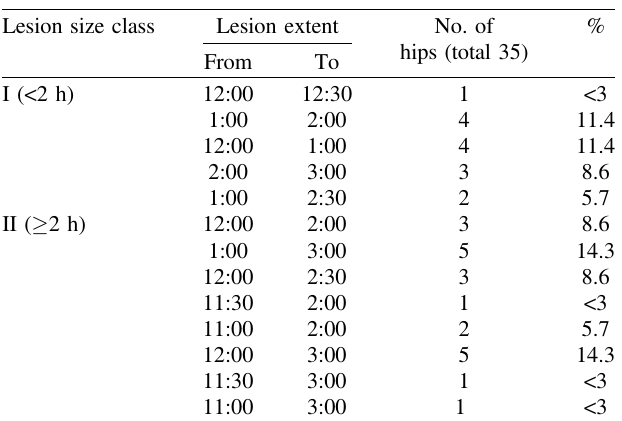
Table 4. Location and extent of cartilage lesions encountered on an imaginary clock face